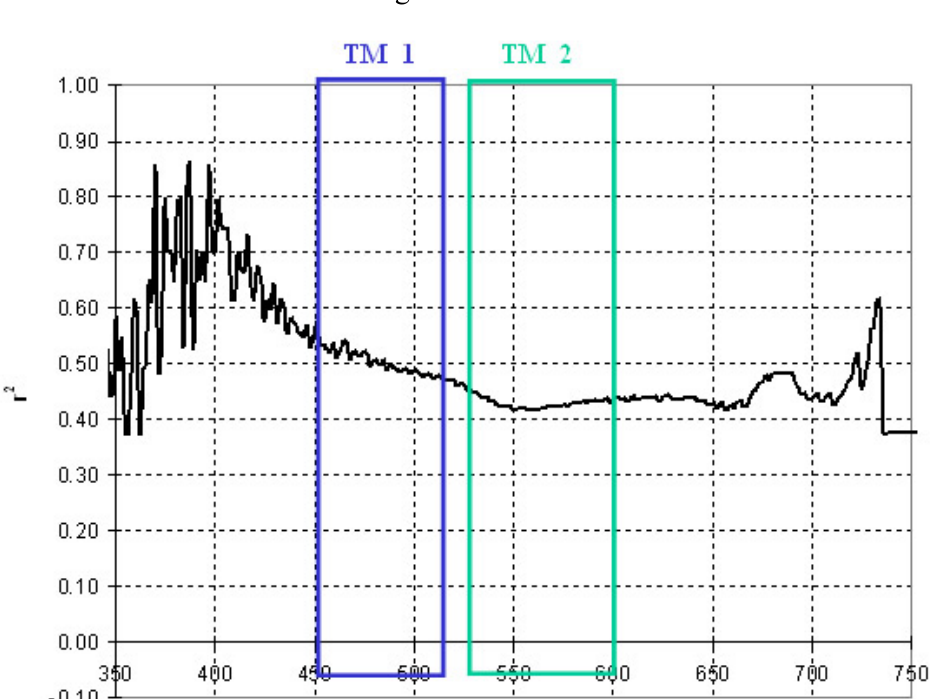
Figure 4. Correlation expressed as r 2 between chlorophyll-a concentration and GER1500 reflectance for Datchet, Wraysbury and Queen Mary reservoirs (23 September 1998). Each r 2 value was calculated at each wavelength of the